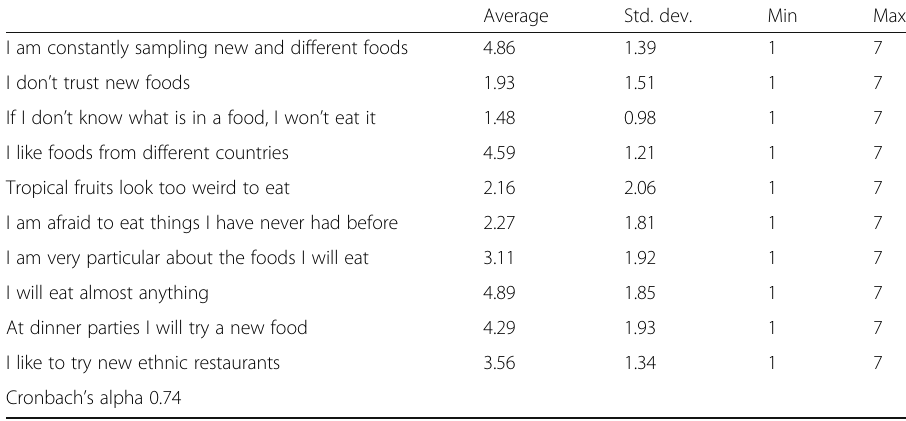
Table 2 Descriptive statistics of the Food Neophilia Scale (FNS) Average Std. dev. Min Max